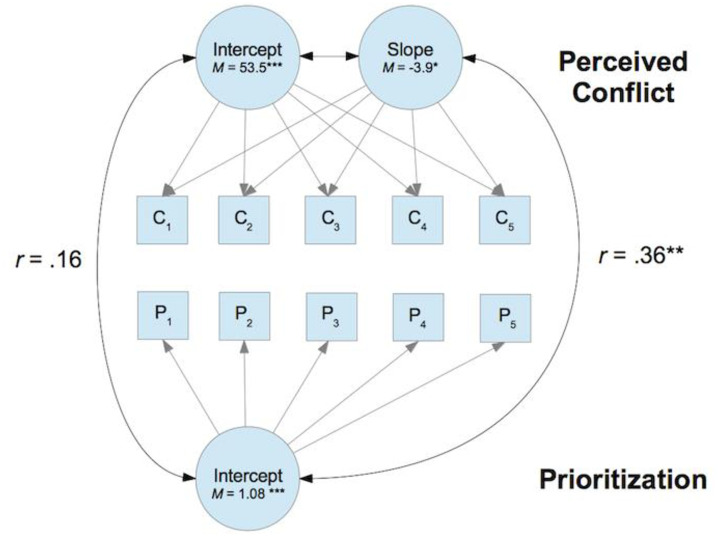
Simplified model depiction of the relation of perceived conflict (C) and prioritization (P) over the course of the five rounds Study 1.Contrary to expectations, prioritization was positively related to perceived conflict.